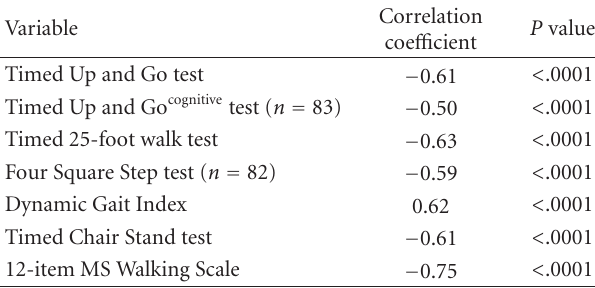
Table 4: Convergent validity between the ABC and the other tests, n = 84 unless other reported. Variable